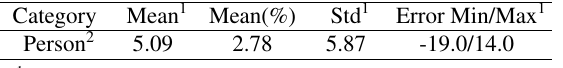
Table 2. Statistic Analysis